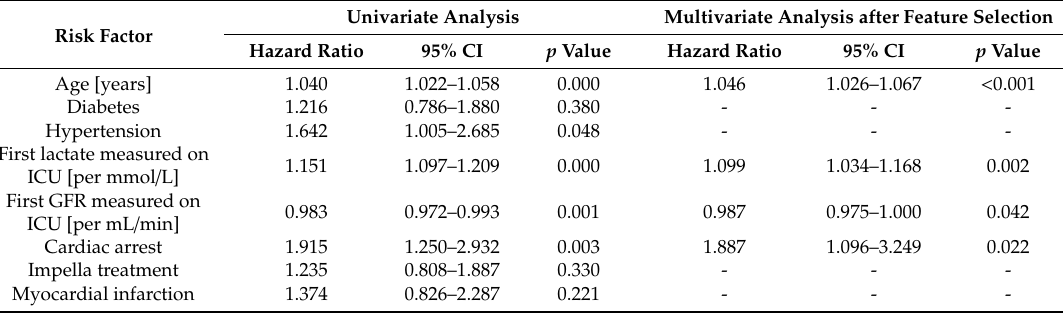
Table 4. Cox proportional hazard regression for long